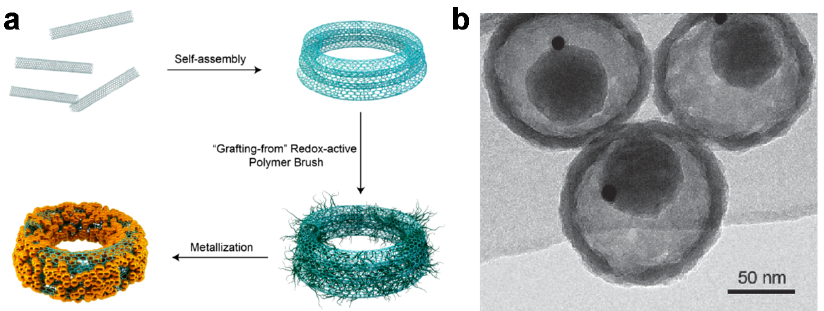
Figure 10. ( a ) Schematic illustration of the self-assembly of carbon nanotubes (CNTs) into a CNT ring (CNTR) and further growth of redox-active poly(4-vinylphenol) (PvPH) brushes via a surface-initiated atom-transfer radical-polymerization (SI-ATRP) method to reduce Au 3+ to Au 0 and coat gold nanoparticles onto the CNTR. Reprinted with permission from [92]. Copyright, American Chemical Society (2016). ( b ) Transmission electron microscopy (TEM) image of carbon-silica nanocapsules with gold nanoparticles (Au@CSN). Reprinted with permission from [93]. Copyright, John Wiley and Sons (2016).